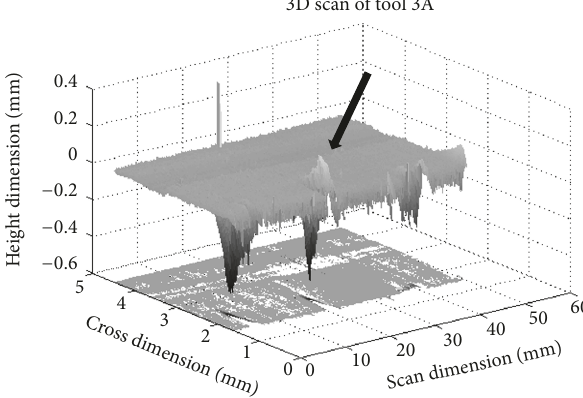
Figure 27: Mesh plot of range